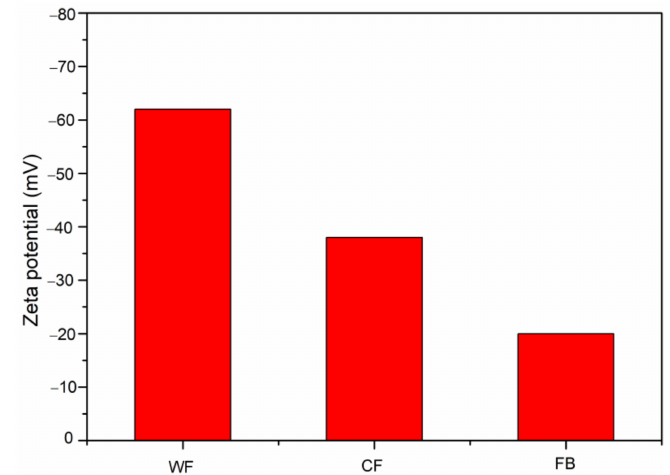
Figure 5. Zeta potential of WF emulsion, CF emulsion, and FB emulsion.